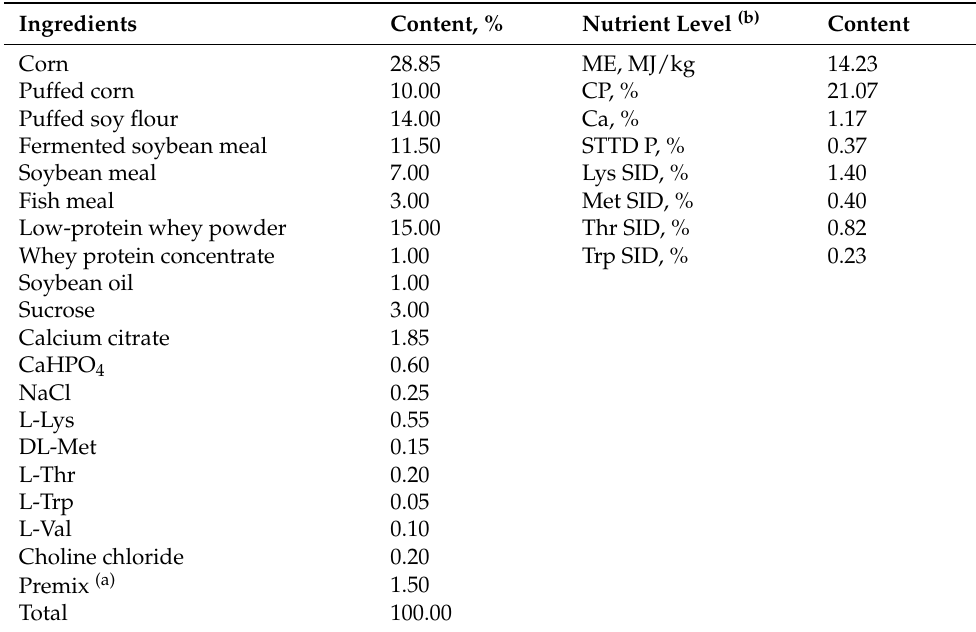
Table 1. Ingredients and nutrient levels of the basal diet (air-dried